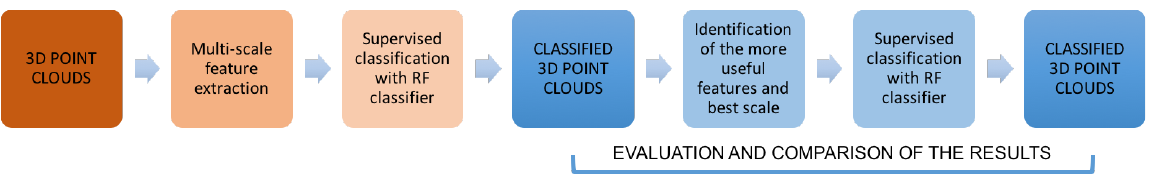
Figure 2. Classification workflow (left) and our extension (right) to evaluate features relevance for the classification process.